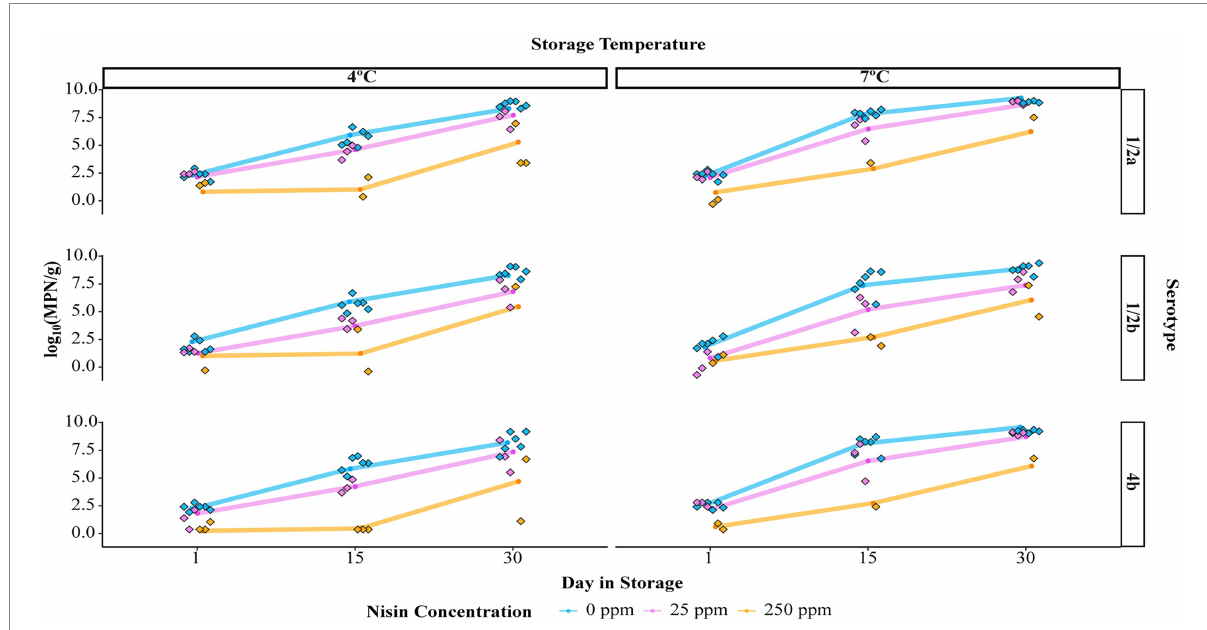
FIGURE 2 Levels of Listeria monocytogenes [in log 10 (MPN/g)] on cold-smoked salmon treated with different concentrations of nisin and stored for up to 30 days. The results are displayed by storage temperature (4 ° C or 7 ° C) and serotype of L. monocytogenes (1/2a, 1/2b, or 4b). Raw data points are plotted as standalone diamonds and estimated marginal means of the L. monocytogenes level (EMMLM) obtained from the mixed effects linear model (the Level Model) are displayed as colored dots connected by solid lines.